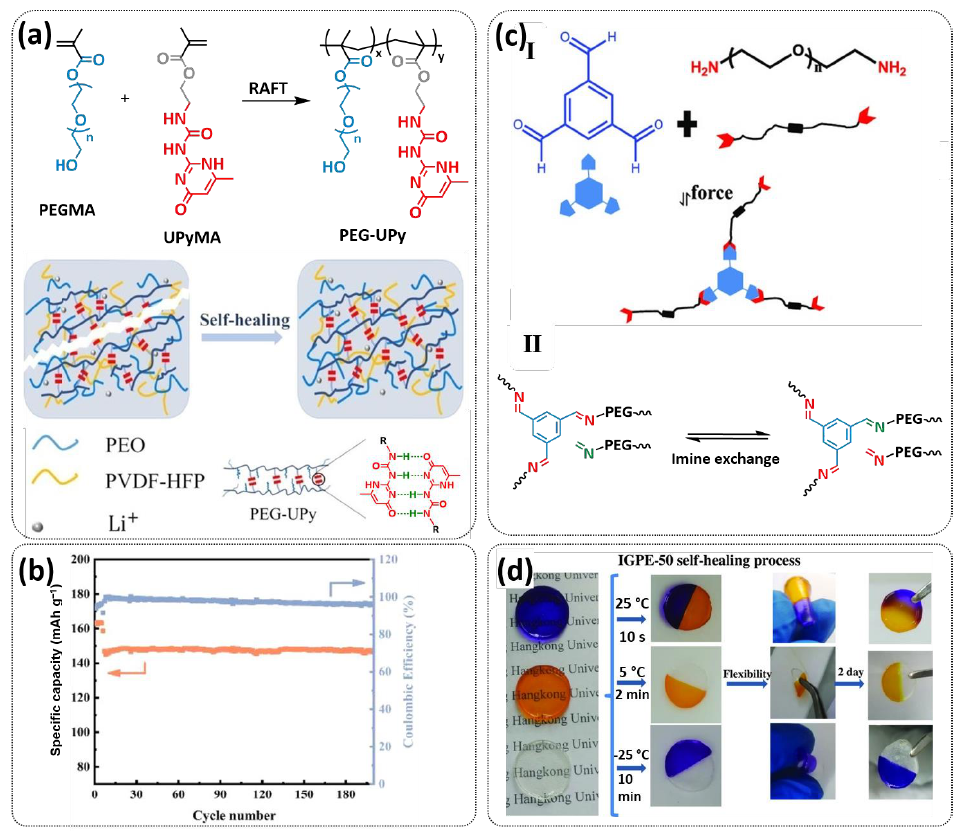
Figure 10. ( a ) Schematic illustration of the synthesis of brush-like copolymer PEG-UPy and the formation of the self-healing GPE. ( b ) Cycling performance and Coulombic efficiency of the Li/GPE-20/LFP cell at 1C. Reproduced with permission from [100]. Copyright © 2022, American Chemical Society. ( c ) Schematic representation of the reversible dynamic imine bond in the IGPE. ( d ) Self-healing process of IGPE-50 at different temperatures. Reproduced with permission from [99]. Copyright © 2021, Wiley-VCH